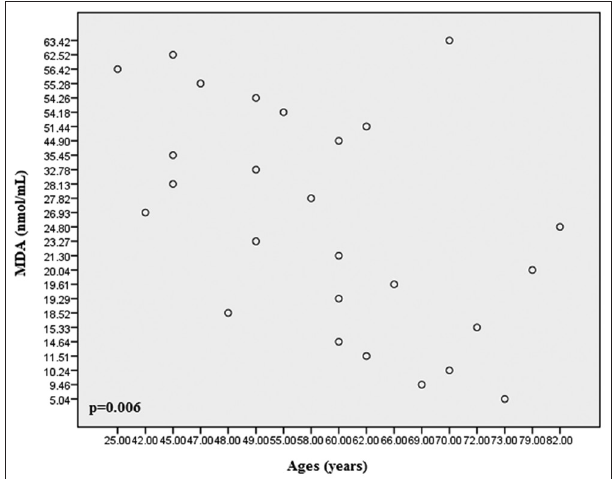
FIGURE 1. Statistically significant correlation between serum malondialdehyde levels and ages of breast cancer patients with